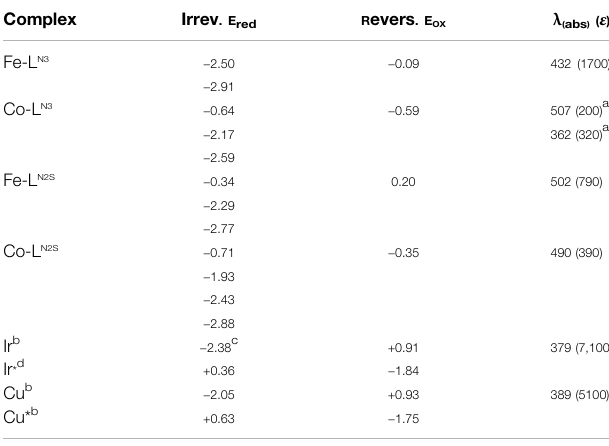
TABLE 1 | Redox potentials [V], excited state redox potentials [V] (marked with *) and MLCT absorption maxima [nm] with corresponding molar attenuation coef fi cients ε [dm 3 mol − 1 cm − 1 ] of the complexes. Peak potentials are given vs. Fc/Fc + .